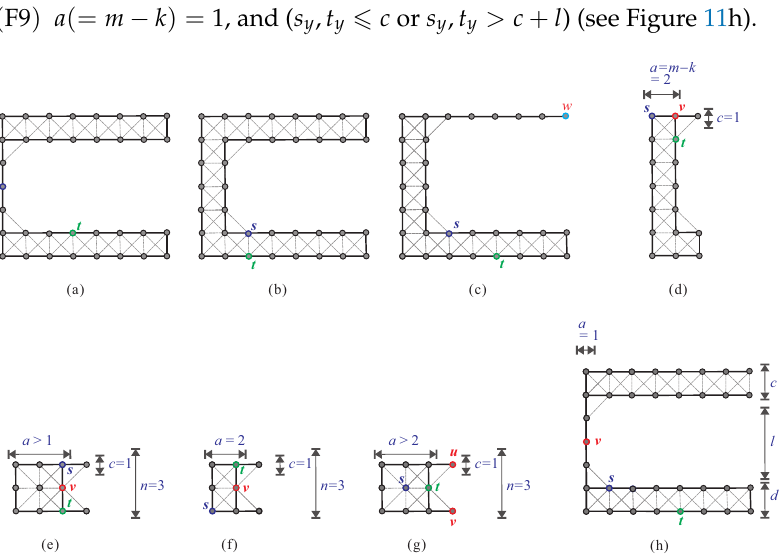
Figure 11. Some C -shaped supergrid graphs in which HP ( C ( m , n ; k , l ; c , d ) , s , t ) does not exist, where ( a , b ) satisfy condition (F1), ( c ) depicts condition (F3), ( d ) depicts condition (F7), ( e – g ) depicts condition (F8), and ( h ) shows condition